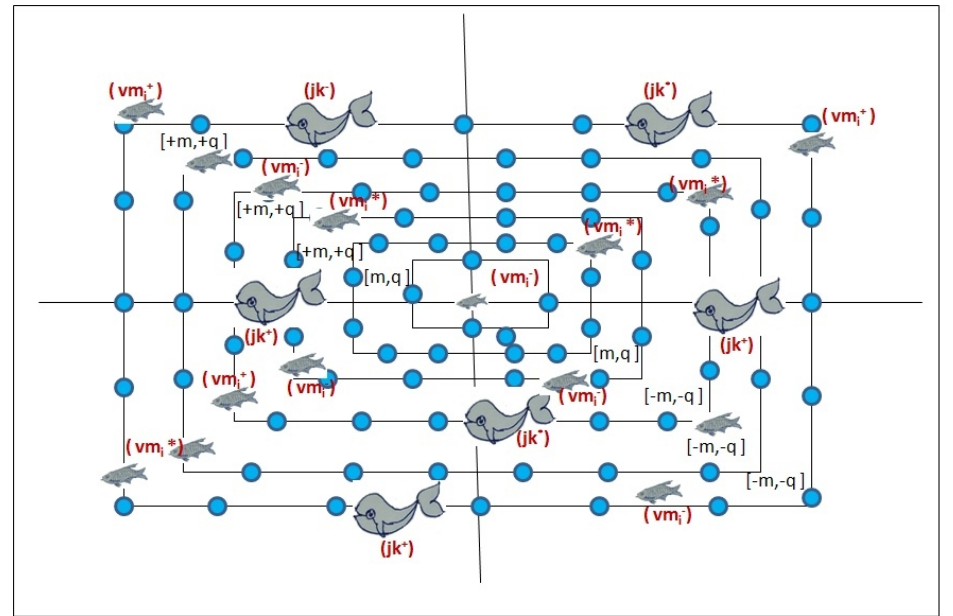
Figure 2: Bubble net hunting strategy of whale optimization load balancing